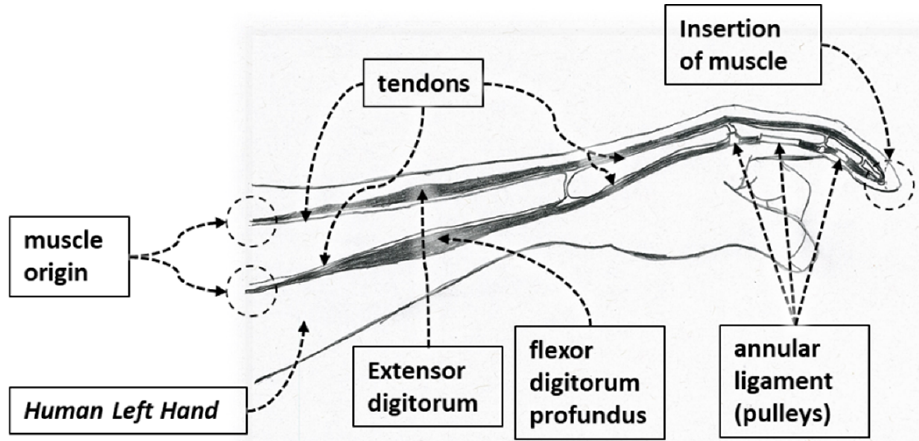
Figure 2. Working mechanism of fingers through muscles, tendons, and pulleys.